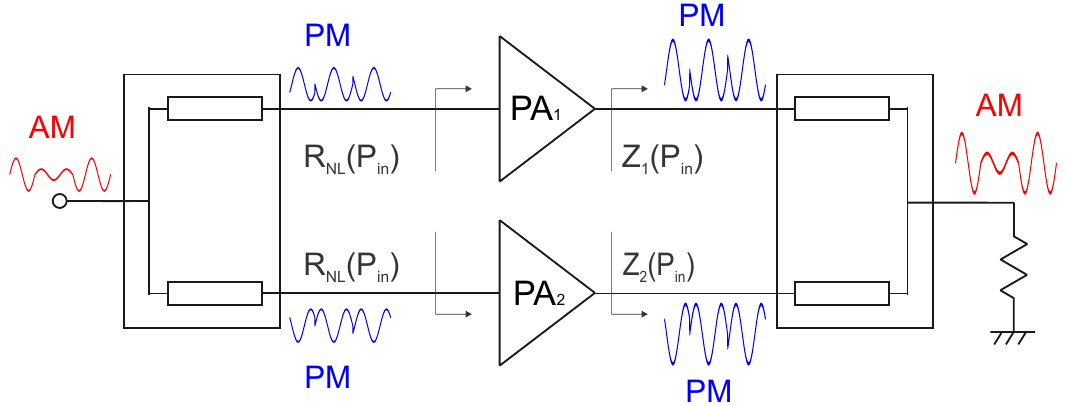
Figure 15. Conceptual scheme for the realisation of a single-input Chireix PA. AM, Amplitude-Modulated; PM, Phase-Modulated.